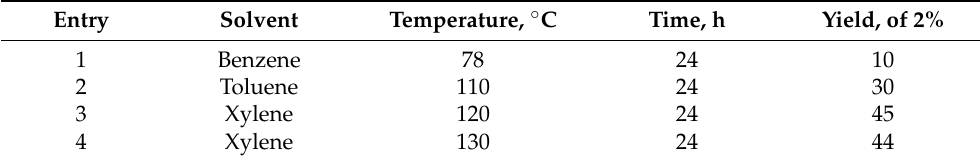
Scheme 1. Synthesis of N , N -bis(4 (cid:48) -(hexyloxy)-[1,1 (cid:48) -biphenyl]-4-yl)thiophen-2-amine 2 . Table 1. Reaction of bis(4 (cid:48) -(hexyloxy)-[1,1 (cid:48) -biphenyl]-4-yl)amine 1 with 2-bromothiophene 3 Table 1. Reaction of bis(4′-(hexyloxy)-[1,1′-biphenyl]-4-yl)amine 1 with 2-bromothiophene 3 .